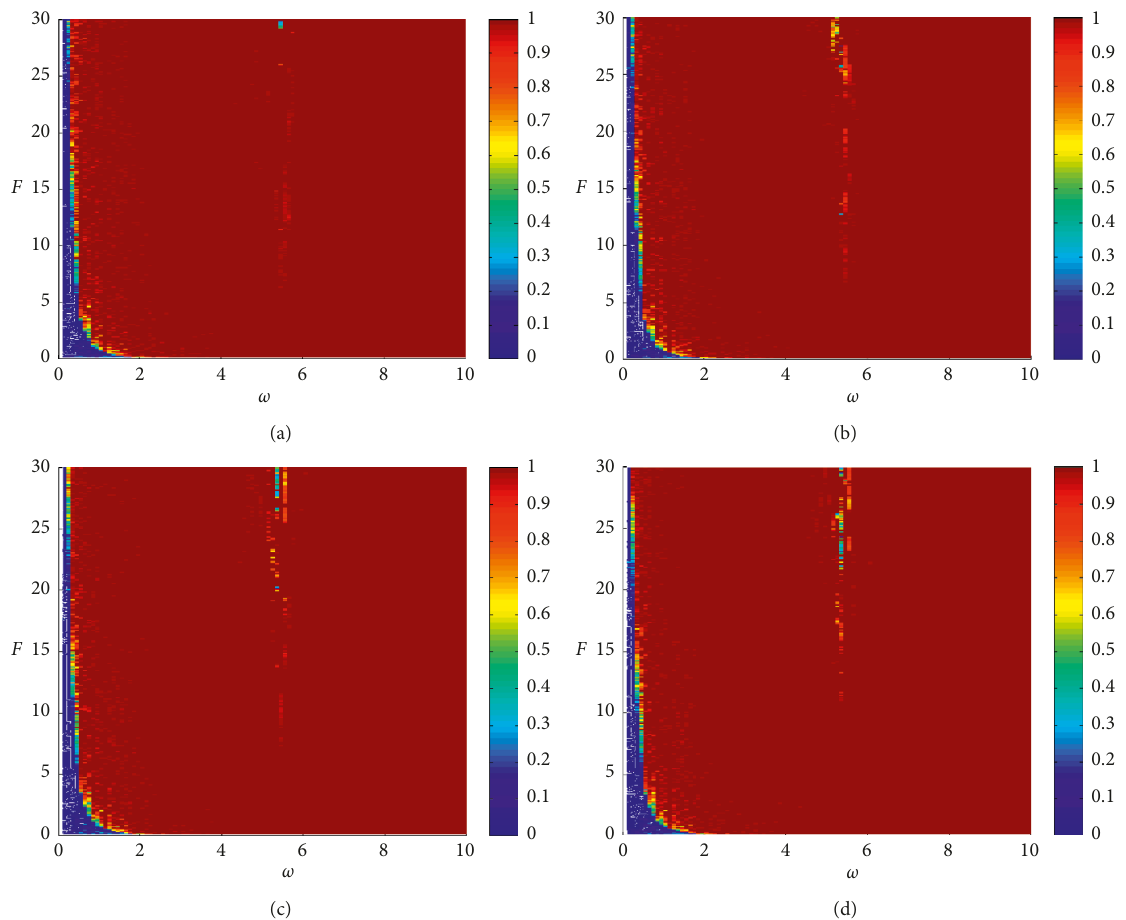
Figure 1: Periodicity of hull dynamic system. (a) α